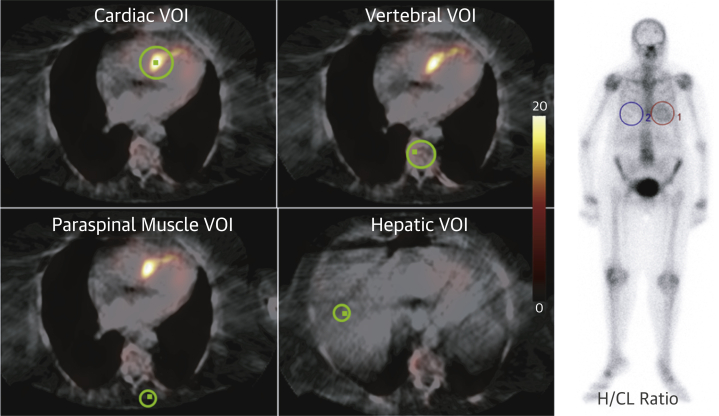
SPECT/CT and H/CL Ratio QuantificationFused axial single-photon emission computed tomography/computed tomography (SPECT/CT) 99mTc-3,3-diphosphono-1,2-propanodicarboxylic acid images demonstrating volume of interest (VOI) (green) positioning for standardized uptake value (SUV) quantification on the left. The small green square within each VOI represents the peak SUV (SUVpeak), which enables the reporter to ensure that the recorded SUVpeak lies within the desired organ/tissue. On the right, 3-h planar, whole-body 99mTc-3,3-diphosphono-1,2-propanodicarboxylic acid image of a different patient with regions of interest over the heart (1) and contralateral lung (4). H/CL = heart/contralateral lung.